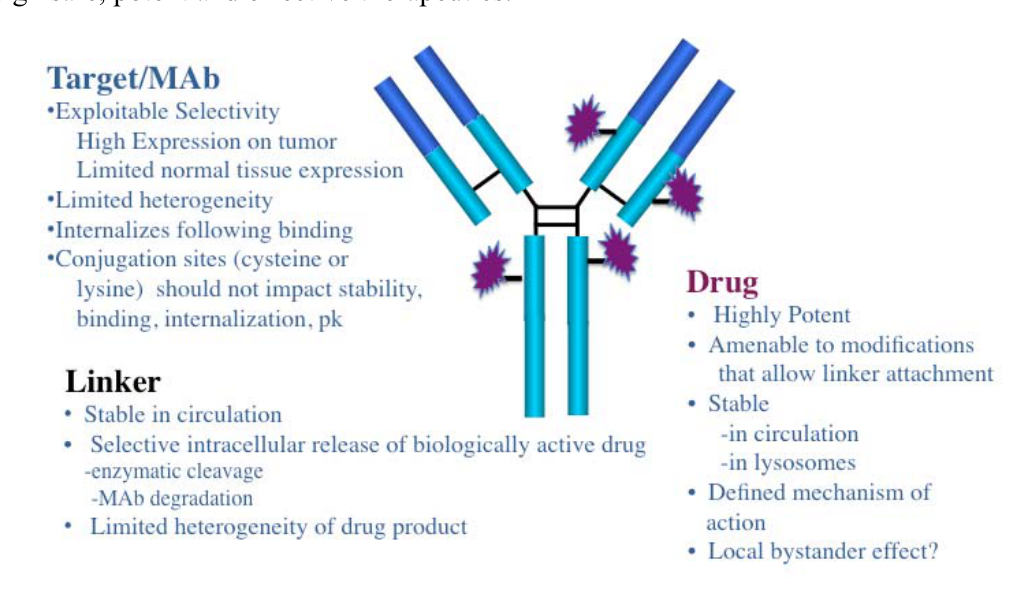
Figure 1. Schematic of an antibody drug conjugate (ADC): An ADC consists of three components, the MAb, linker, and cytotoxic drug each of which must be optimized to design safe, potent and effective